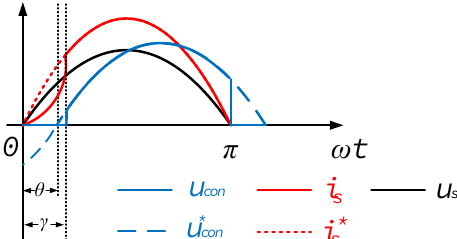
Figure 6. Expected waveforms and actual waveforms of the AC-side fundamental voltage and current of bridgeless rectifier under a unity power factor.